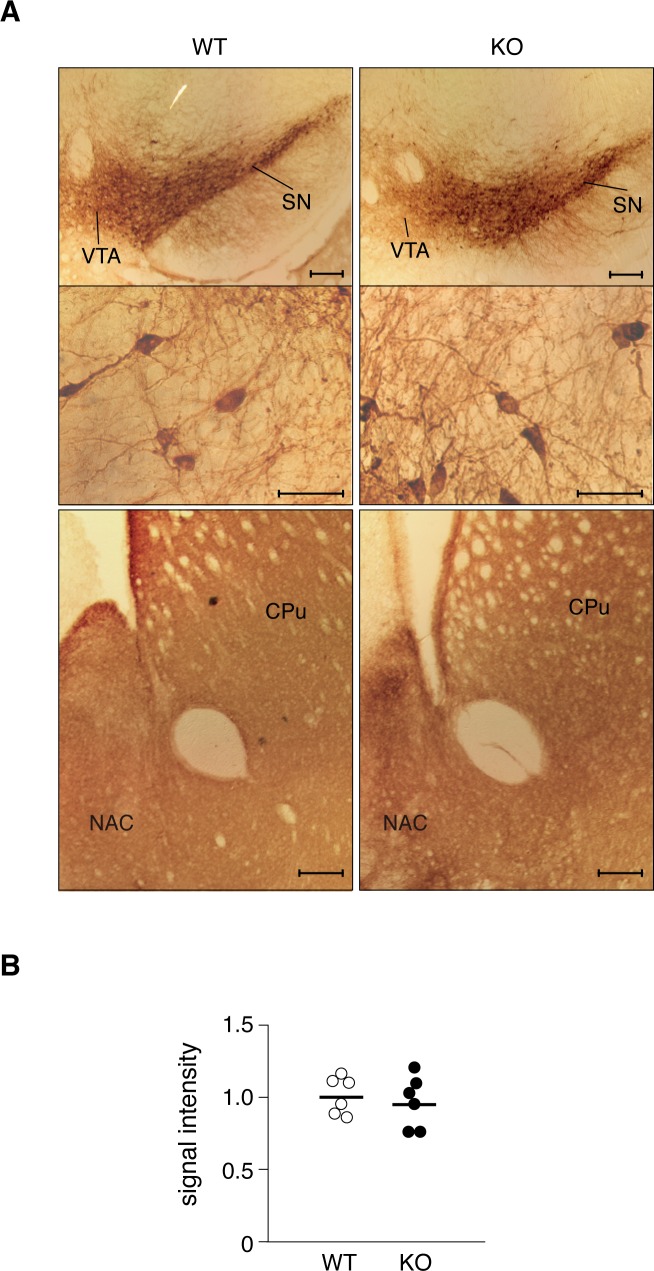
No histological changes in dopaminergic pathways in the brain of Ptprz-KO mice.(A) Immunohistochemistry of coronal brain sections by anti-tyrosine hydroxylase. Images are the midbrain region with low- (top panels) and high- (middle panels) magnification, and striatum (bottom panels). Scale bars, 500 μm (top and bottom panels) and 50 μm (middle panels). CPu, caudate putamen; NAc, nucleus accumbens; SN, substantia nigra; and VTA, ventral tegmental area. Results are representative of six individual mice. (B) Comparison of the signal intensity of anti-TH staining in the striatum. The scatter plot shows individual values of the signal intensity relative to that of averaged values of wild-type mice (n = 6 per group). There were no significant differences between the genotypes (P = 0.480 by the Student’s t-test).